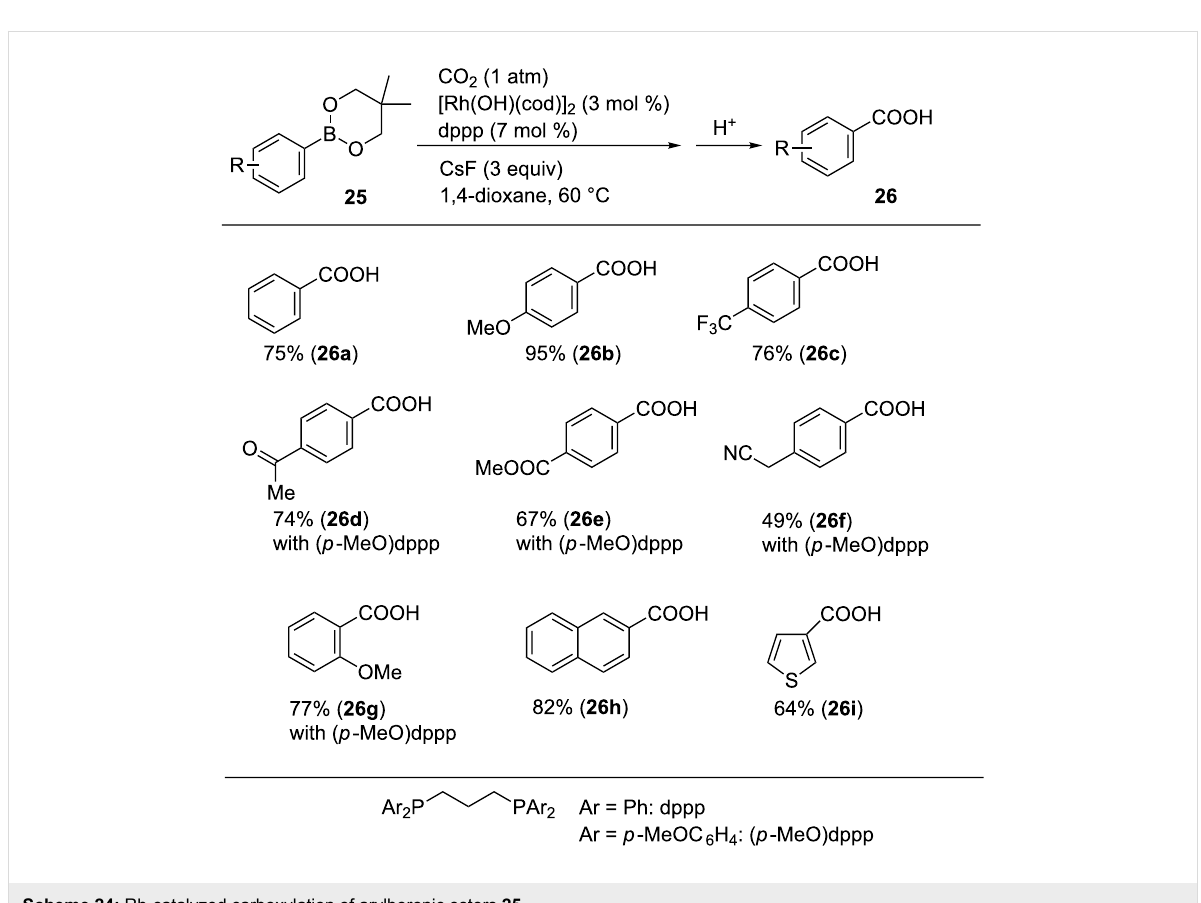
Scheme 24: Rh-catalyzed carboxylation of arylboronic esters 25